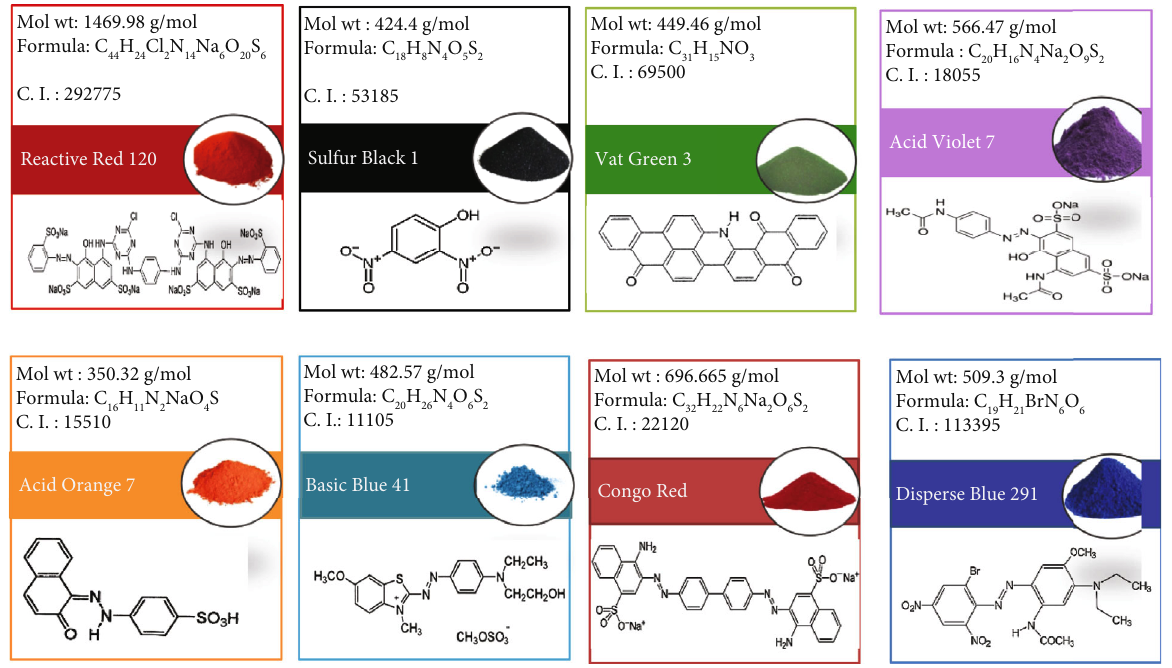
Figure 2: Basic characteristics of some dyes mentioned in literature. Table 1: Advantages and disadvantages associated with di ff erent dye removal techniques